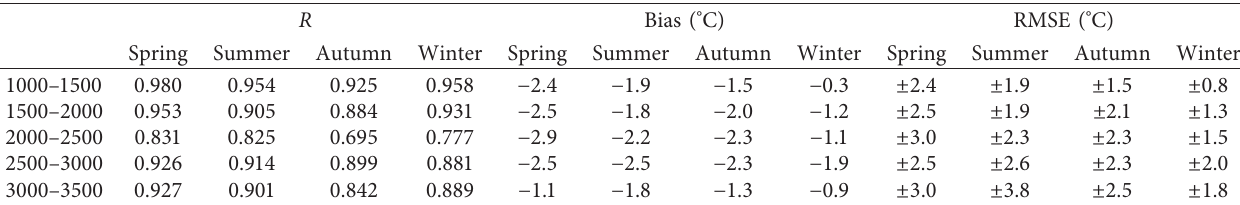
Table 6: Seasonal averaged ( r ), bias, and RMSE for different elevation